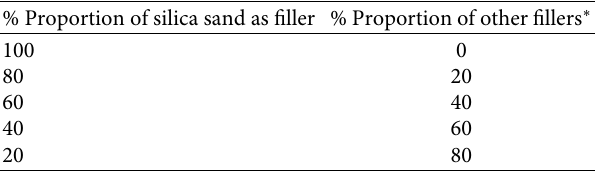
Figure 7: Development Approach of Polymer-Based lightweight concrete. Table 7: Proportion of fillers with a polyol of resin for choosing optimum